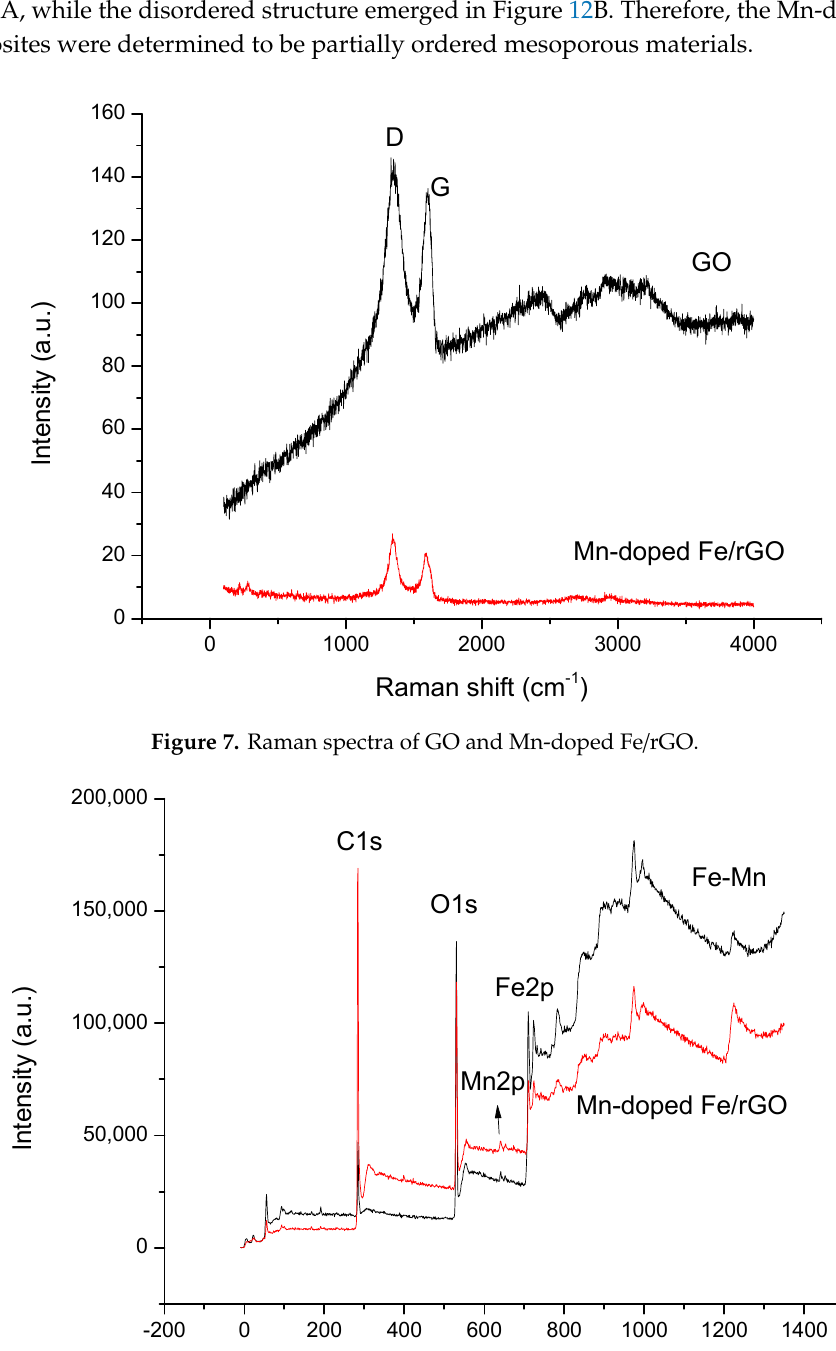
Figure 8. XPS survey spectra of Fe–Mn NPs and Mn-doped Fe/rGO composites.